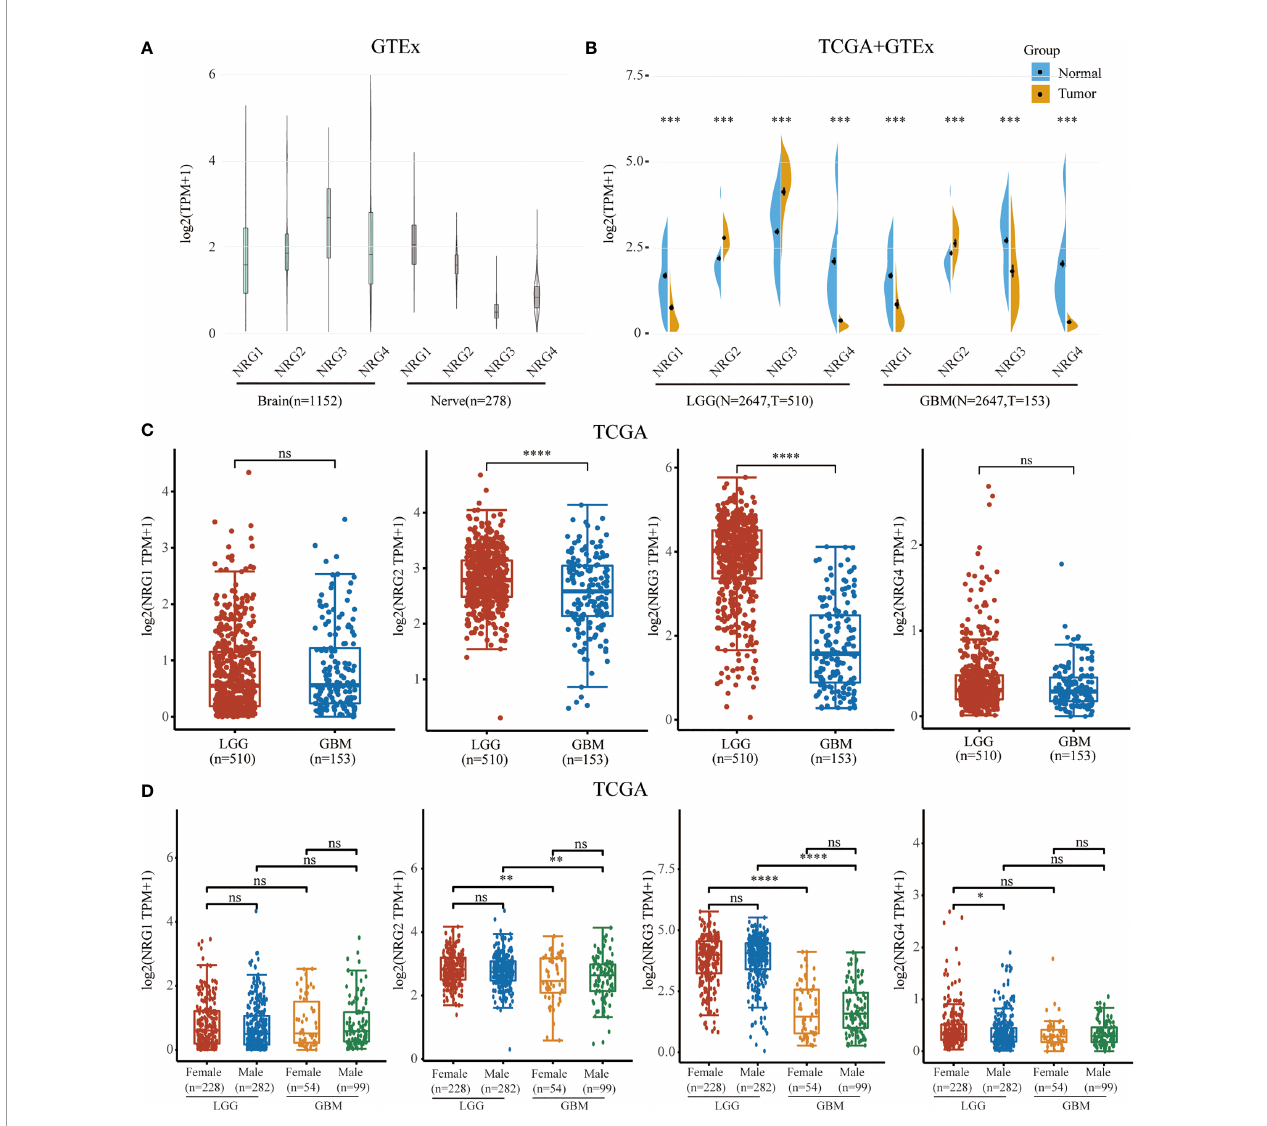
FIGURE 1 | mRNA expression level of NRG family members. NRGs expression levels in the brain (n=1152) and nerve (n=278) from GTEx database (A) . NRGs expression levels in LGG (n=510), GBM (n=153) and normal tissues from GTEx (n=2642) and TCGA (n=5) database (B) . NRGs expression levels in LGG (n=510) and GBM (n=153) from TCGA database (C) . NRGs expression levels in patients of different genders with LGG (Female: n=228; Male: n=282) and GBM (Female: n=54; Male: n=99) (D) . The signi fi cance of the two groups of samples passed the Wilcox test. ns, no signi fi cance; *P < 0.05; **P < 0.01; ***P < 0.001; ****P <